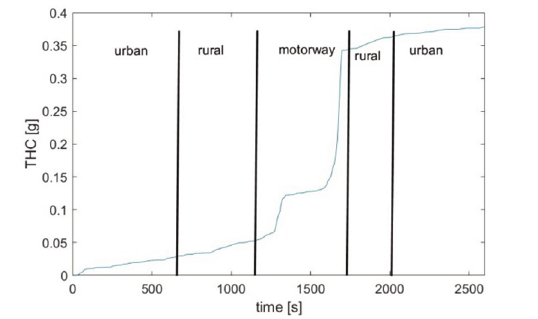
Fig, 10. Emission of THC for Euro 6 LPG fuelled vehicle Graphs of NO emissions intensity as a function of ac- x celeration and velocity are presented in Fig. 11–14.